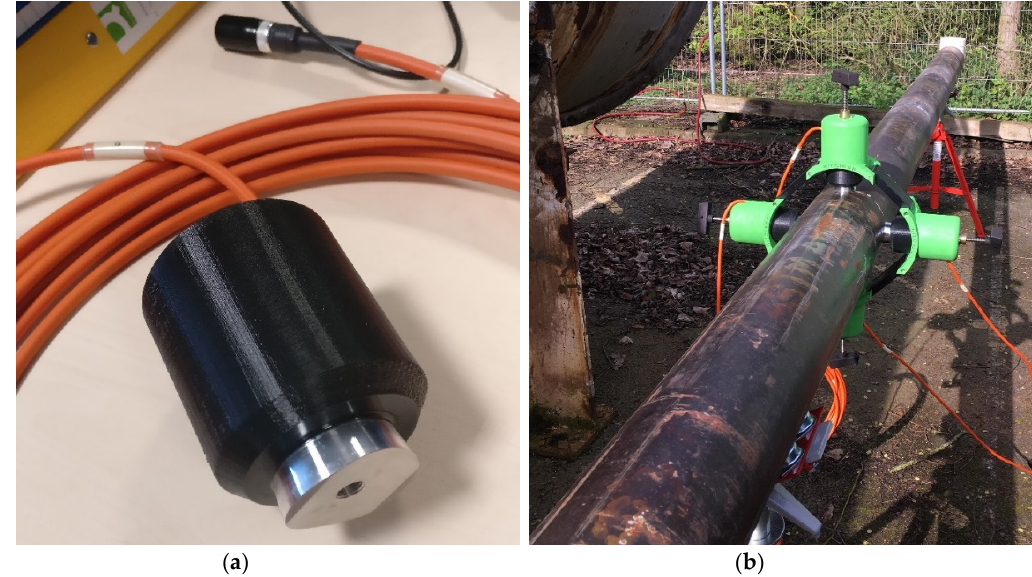
Figure 9. ( a ) Marinized HPUT with marinized cabling and ( b ) marinized HPUTs placed into prototype HPUT collar to commence laboratory investigations.